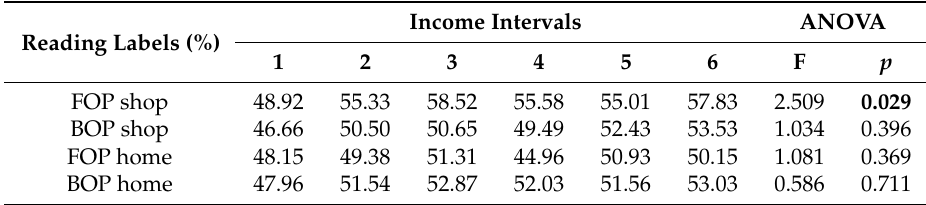
Table 6. Reading food labels by income.